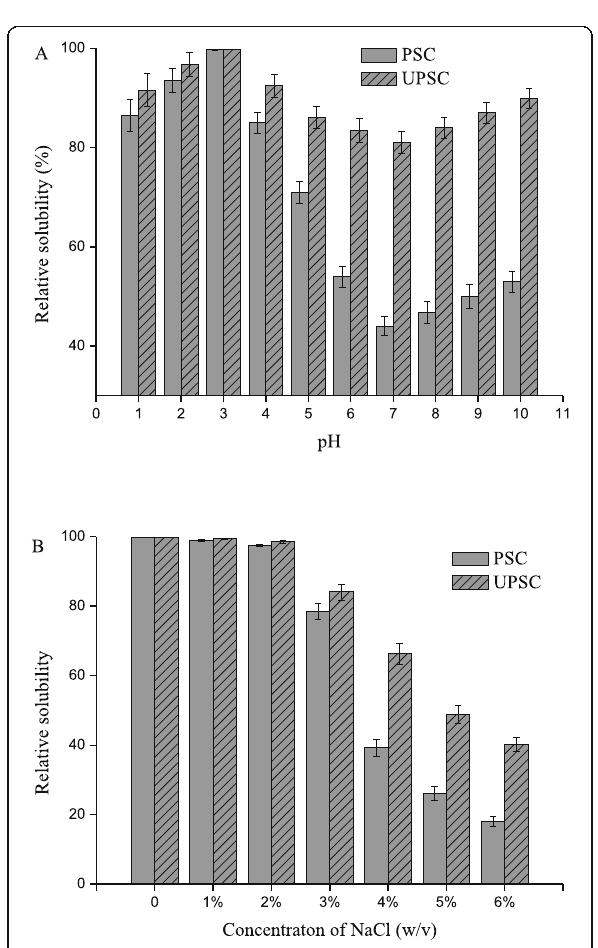
Fig. 7 Relative solubility (%) of PSC and UPSC from chicken lung as affected by different environmental factors. a pH; b concentration of